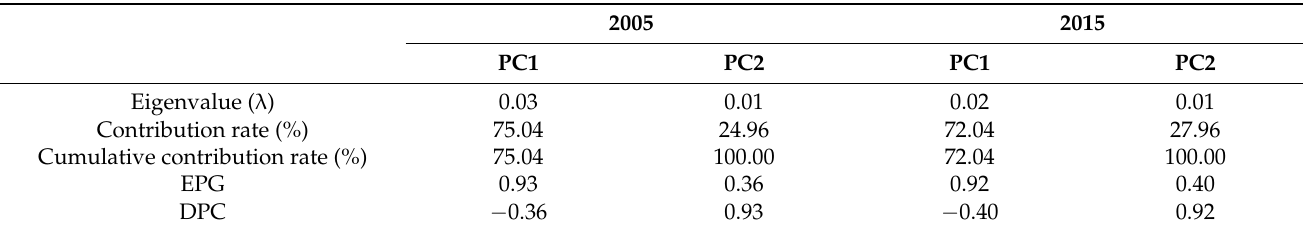
Table A4. Eigenvalues and correlation coefficient matrix of principal components of response indicators in 2005 and